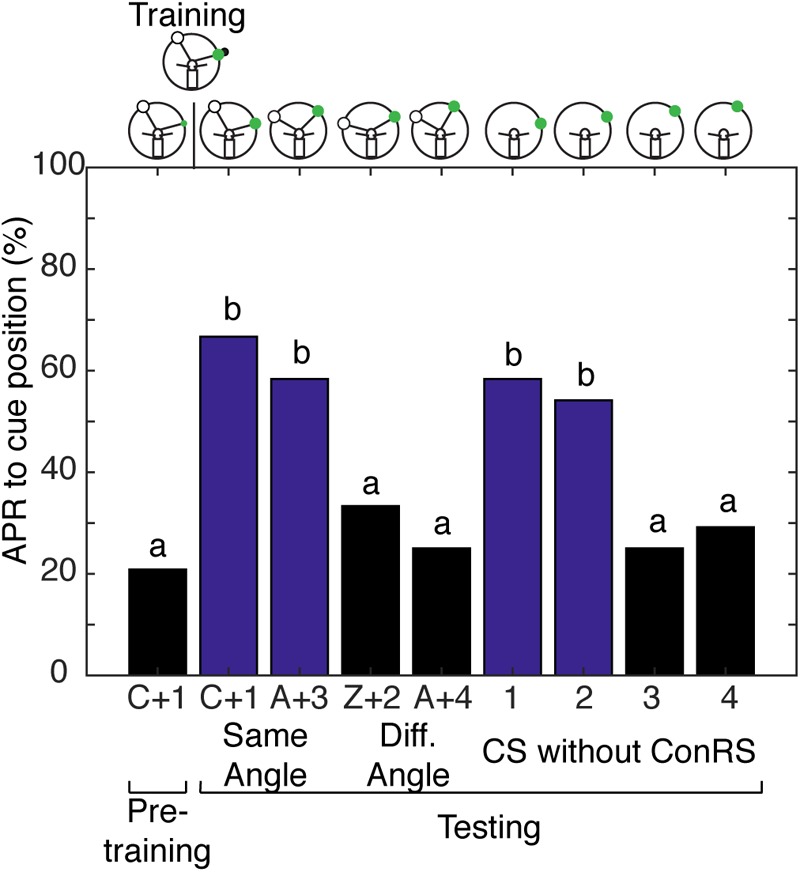
Antennal projection responses demonstrate multiple representations of space. The APRs of cockroaches (n = 24) that were trained in the presence of a contralateral reference cue were examined with different configurations of the ConRS and CS. When tested, the APR to the CS in the presence of a ConRS were significantly different (χ2 = 22.67, P = 4.739E-5). When tested at positions that maintained the ConRS–CS training relationship, APRs were significantly different from pretraining (χ2 = 18.73, P = 8.58E-5), but not different from each other (z = 0.5777, P = 0.5643). When tested with other configurations that had larger or smaller angular relationships the APRs were not significantly different from each other (z = 0.6154, P = 0.5383) or pretraining (χ2 = 4.67, P = 0.097). When tested without the ConRS and only the CS at positions 1–4, the APRs were significantly different from each other (χ2 = 20, P = 0.0002). There were significant APRs when the CS was presented within 15° of the learned position (1 and 2), but not when the CS was presented at other locations (3 and 4) (1 and 2 vs. pretraining, n = 24, χ2 = 16.23, P = 0.0003; 3 and 4 vs. pretraining, n = 24, χ2 = 3, P = 0.2231). The APRs to positions 1 and 2 were not significantly different from each other (z = 0.2759, P = 0.7826), nor were the APRs to positions 3 and 4 (z = –0.308, P = 0.7581). Bar colors and letters reflect statistical groups. The illustrations above the graphs represent the position of cues during the experiment.